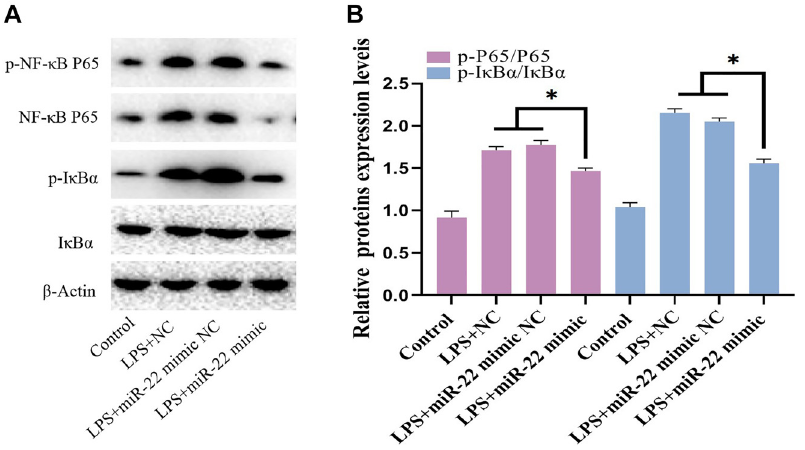
Figure 5: Effects of miR-22-3p on the NF- κ B signaling pathway. Total protein was extracted using RIPA lysis buffer. Protein concentrations were determined using the bicinchoninic acid (BCA) kit. Equal amounts of protein (30 μ g/Lane) from each sample were subjected to SDS-PAGE and transferred onto apolyvinylidene fl uoride (PVDF) membrane. The membranes were then treated with 5% skim milk powder at 4 ° C overnight. After washing, the PVDF membranes were treated with the primary antibodies (NF- κ B, 1:500 dilution; NLRP3, 1:1,000) at 4 ° C overnight, followed by incubation with HRP-conjugated secondary antibodies (1:2,000 dilutions) for 1 h at RT. The immunoreactive bands were visualized by ECL detection